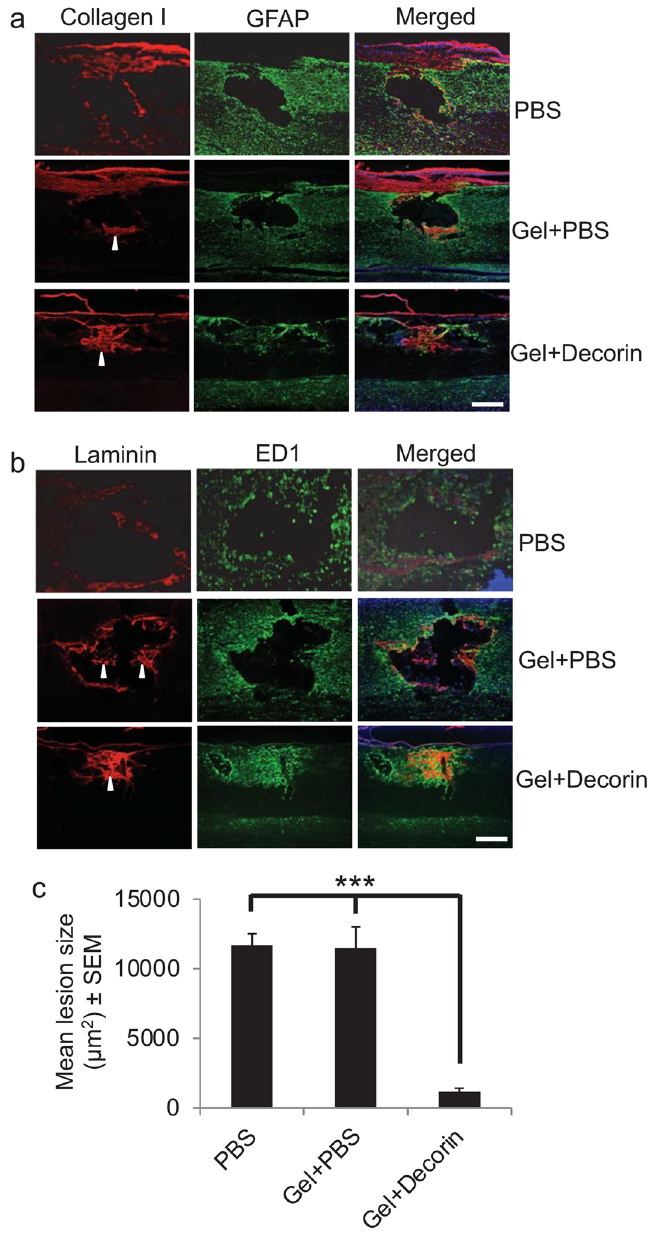
Figure 3. Gel + Decorin enhances deposition of ECM molecules within the DC wound core and reduces cavity size. ( a ) DC injury + PBS treatment normally generates a cavity in the lesion site but even with Gel + PBS small amounts of collagen I persisted (arrowhead) within the lesion site. However, in Gel + Decorin-treated lesion sites, both ( a ) collagen I (arrowhead) and ( b ) laminin (arrowhead) filled the lesion core. ( a ) GFAP and ( b ) ED1 + cells filled the lesion site after Gel + Decorin treatment but were restricted to the cavity edge in Gel + PBS injected rats. ( c ) Gel + Decorin injections significantly suppressed wound cavity size. *** P < 0.0001, one-way ANOVA with Dunnett’s post hoc test. Scale bars in ( a ) and ( b ) = 200 µm. n = 4 rats/group, 3 independent repeats, total n = 12